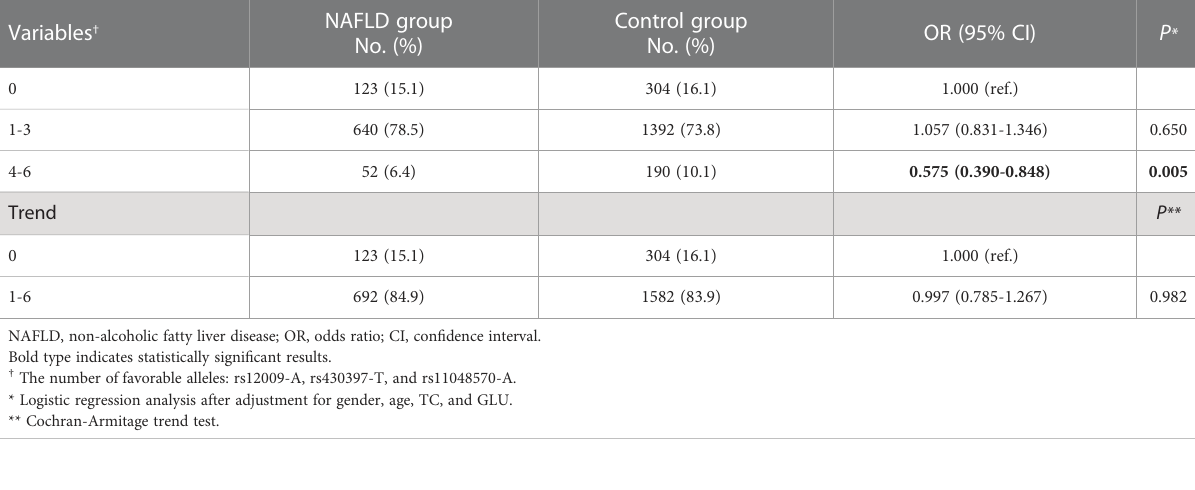
TABLE 3 Combined effects of rs12009-A, rs430397-T, and rs11048570-A on NAFLD